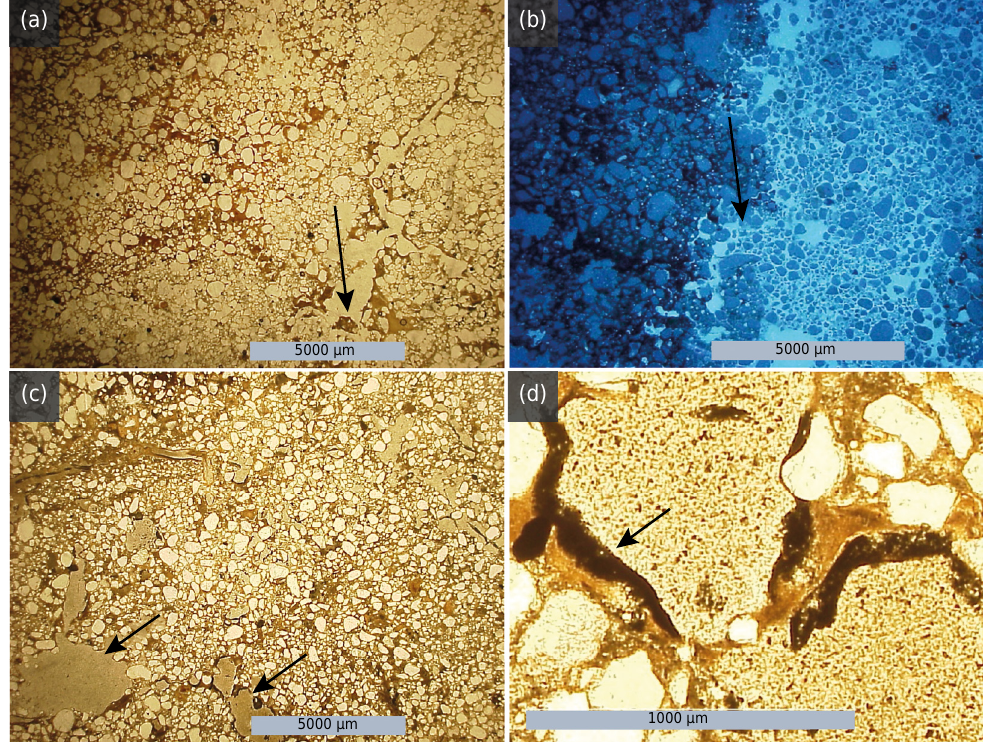
Figure 7. Photomicrograph of the 2Btgn1 horizons of P5; arrows indicating argilluviation (a), loss of clay and residual sand concentration (b), porphyritic texture with many ferrolysis dissolution/ depletion cavities, and intense argilluviation, (c) pre-coalescence stage of the dissolution/depletion cavities: the presence of ferrans on the clay coatings is in agreement with the dynamics proposed by Brinkman (1970) for ferrolysis (d).